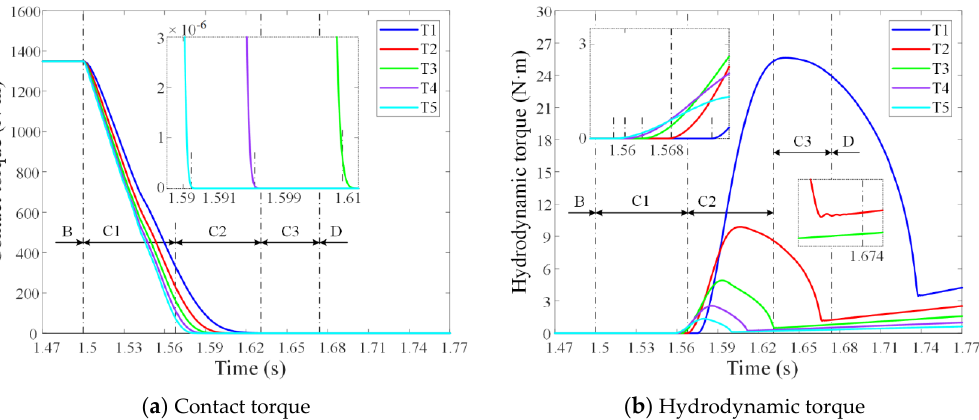
Figure 6. Variations of torques in the disengaging process with different ATF temperatures. As the ATF temperature increases from 60 °C to 140 °C, the end moment of the boundary lubrication stage brings forward from 1.575 s to 1.558 s, and the durations of the boundary lubrication stage are 0.075 s, 0.068 s, 0.063 s, 0.06 s, and 0.058 s, respectively.